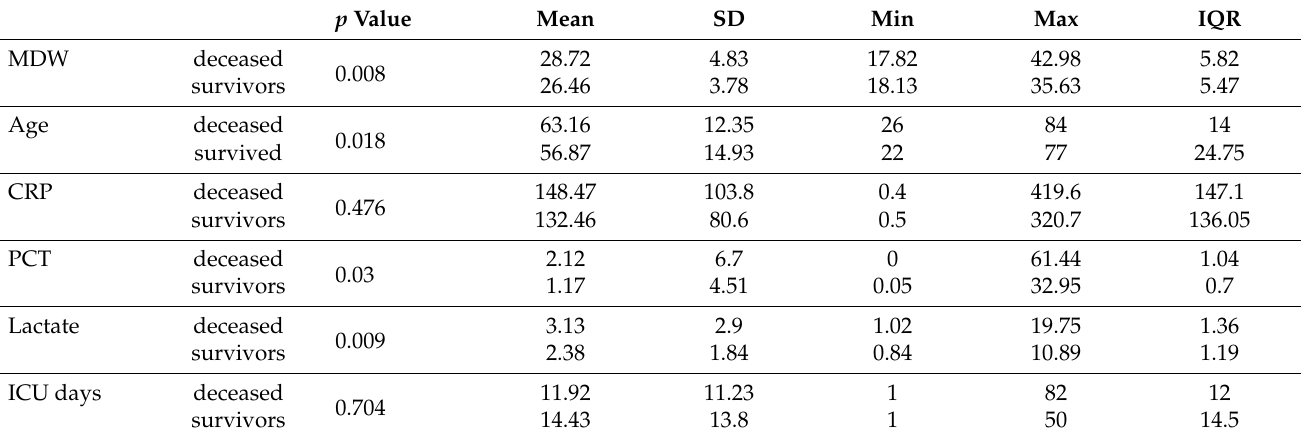
Table 1. Mann–Whitney U test was performed for group comparison (deceased and survived) and obtained p values are presented in the table. Descriptive statistics for selected variables (MDW, age, CRP, PCT, lactate, and ICU days) in certain groups are expressed as mean, standard deviation, minimum and maximum values, and interquartile range.